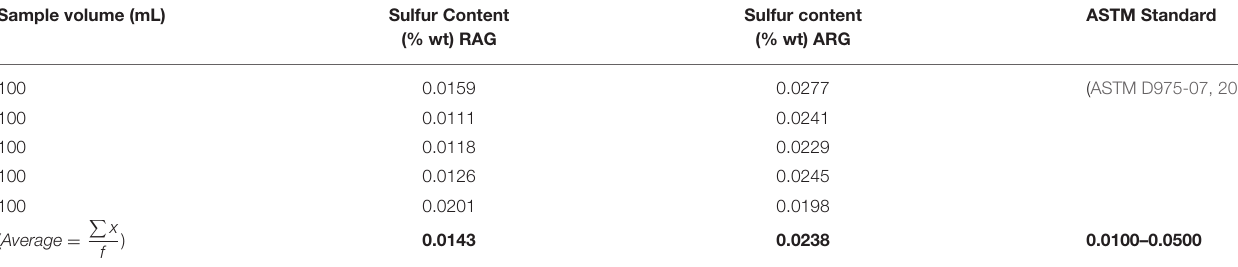
TABLE 7 | Sulfur content of regular automotive gasoline (RAG) and artisanal refined gasoline (ARG). Sample volume